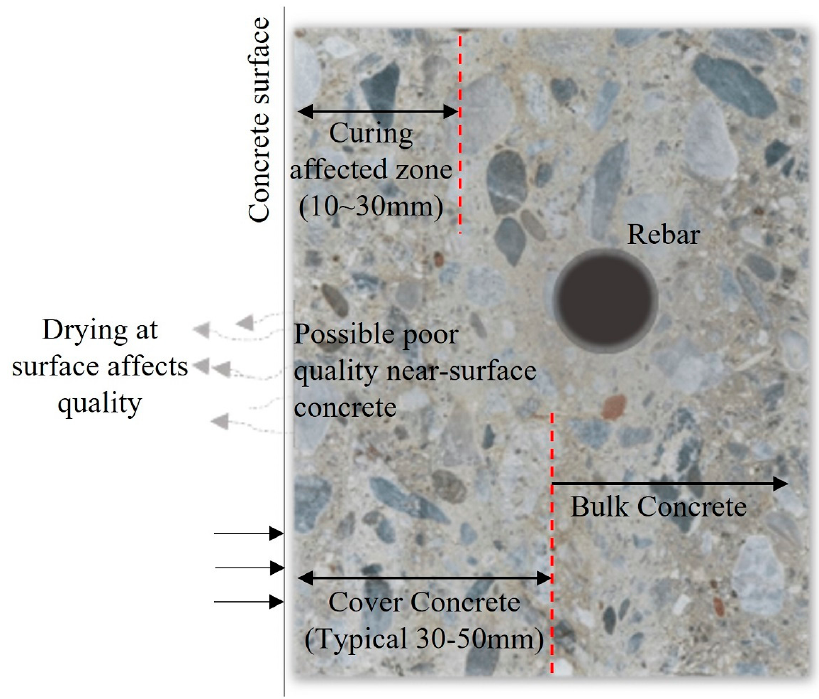
Figure 1. Schematic illustration of corrosion attack path in RC [48]. Reproduced with permission from Elsevier 2023.